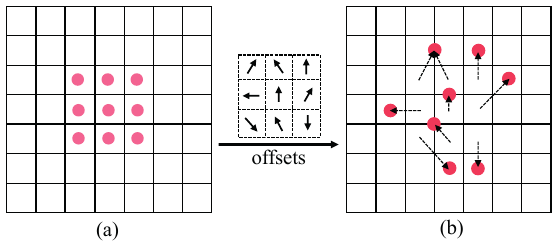
Figure 2. Deformable convolutional network. (a) is the common convolution with the 3x3 kernel, and (b) is the deformable convolutional network after the 3x3 convolution kernel with the